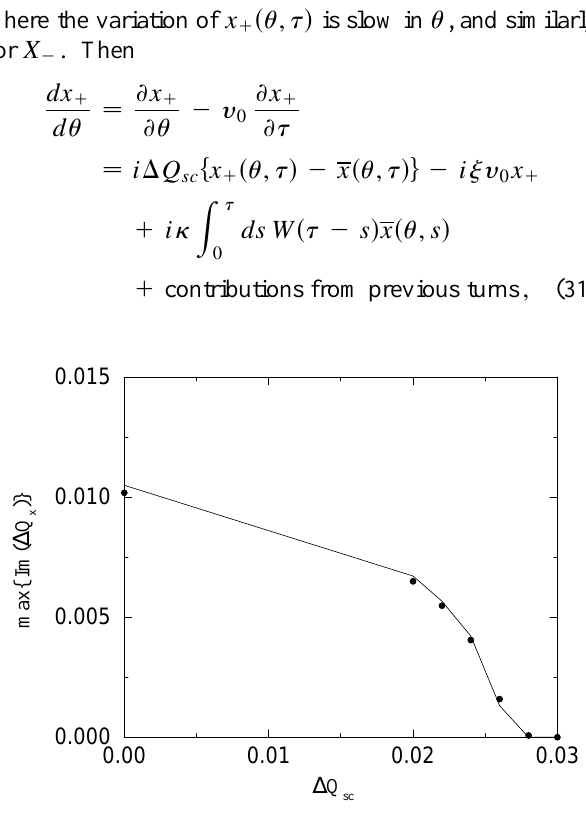
FIG. 11. Largest value of Im (cid:115) D (cid:81) (cid:120) (cid:100) vs D (cid:81) (cid:115)(cid:99) from simulations with (cid:81) (cid:115) (cid:173) (cid:48)(cid:46)(cid:48)(cid:49) and different longitudinal forces: m (cid:173) 2 (cid:49) (cid:121) (cid:50) in a quadratic potential, circles; square well model, solid